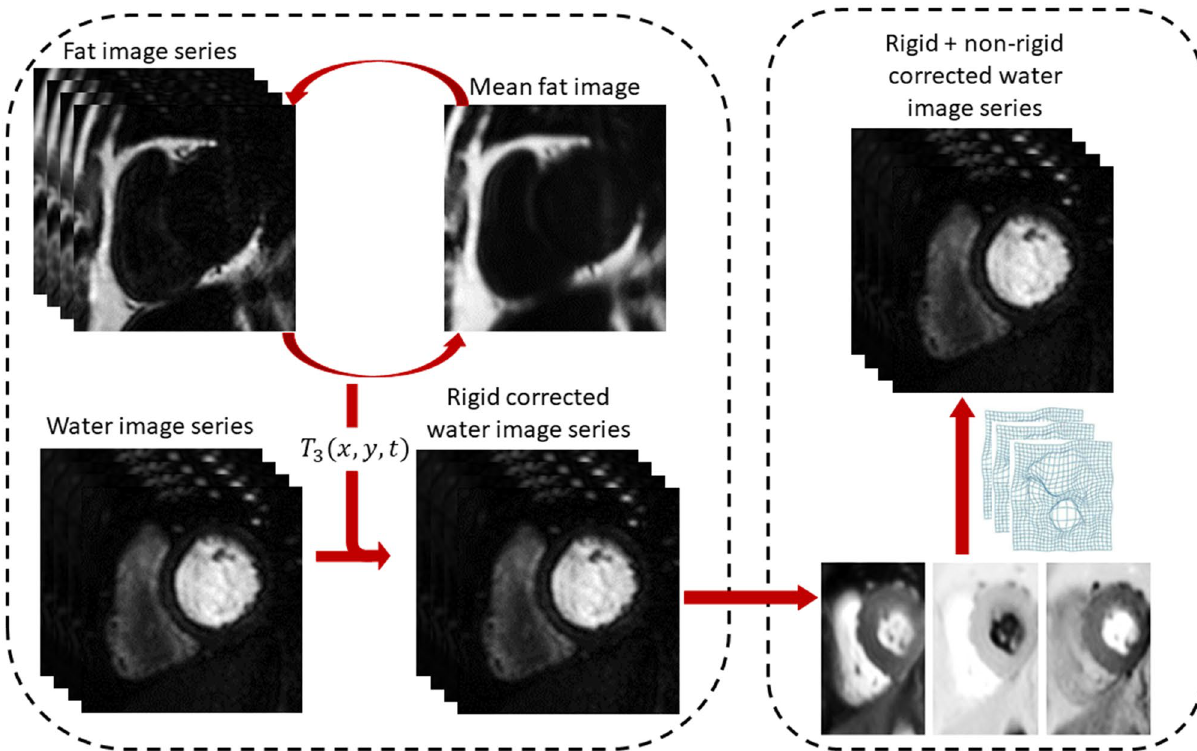
Figure 2. A flow chart which describes the proposed two-step motion correction scheme. The fat images obtained from the multi-echo Dixon reconstruction are used to correct for the rigid body bulk motion. This is done in an iterative fashion. For three iterations the fat images are registered to the mean fat image, which updates on each iteration, resulting in transformations T 1 ( t ) , T 2 ( t ) and T 3 ( t ) for each time dynamic t .